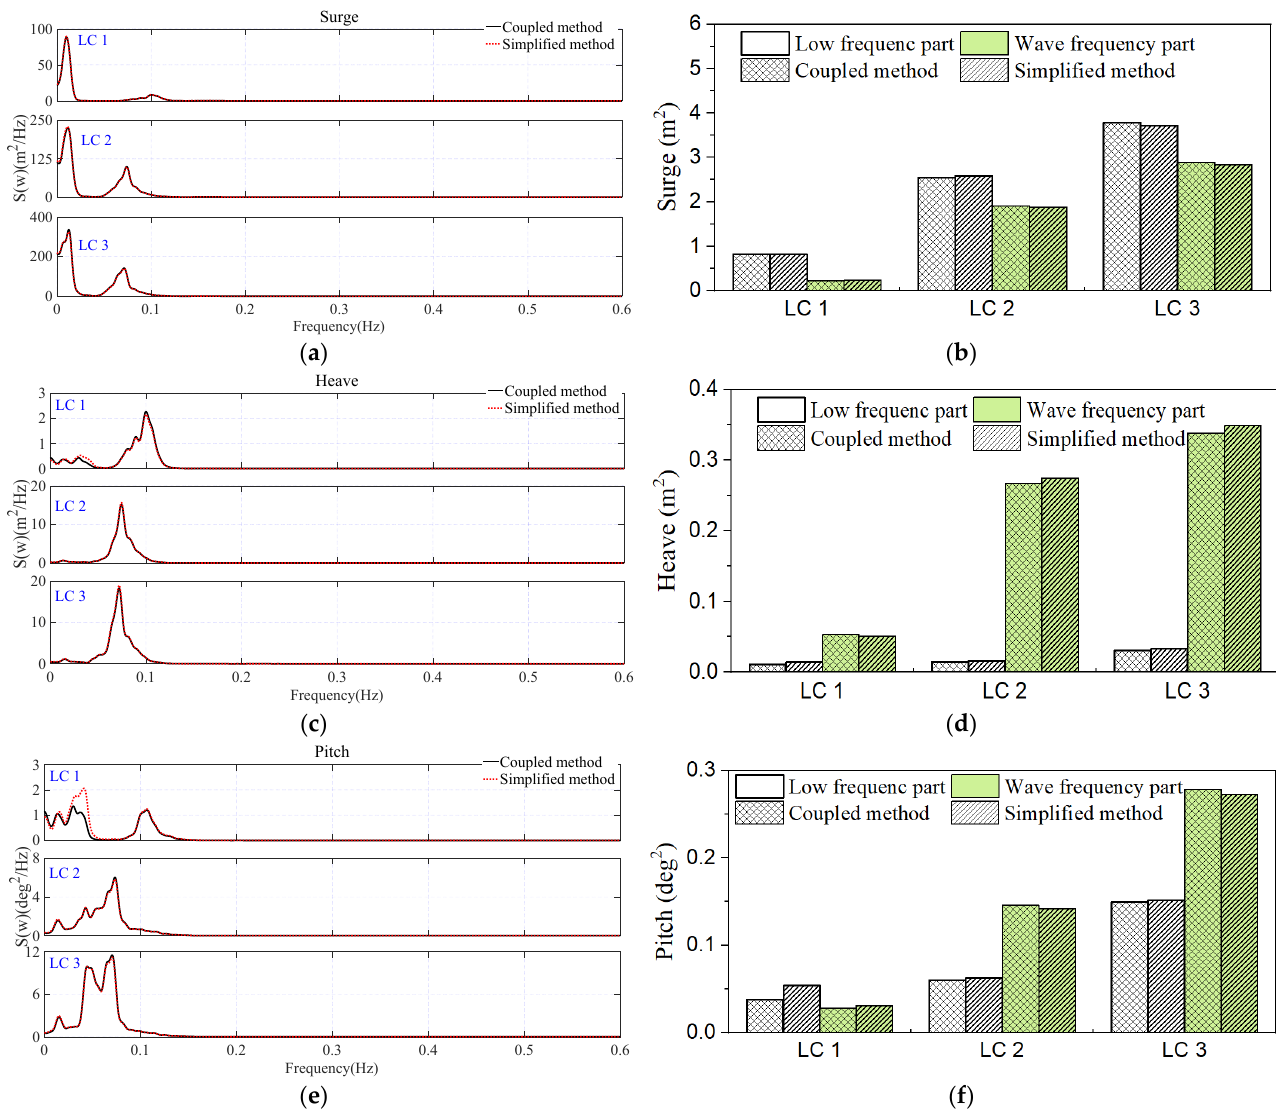
Figure 13. PSD plot of surge, heave, and pitch motion for WindFloat SFOWT platform under different load cases: ( a ) Surge; ( b ) Integrals of surge; ( c ) Heave; ( d ) Integrals of heave; ( e ) Pitch; ( f ) Integrals of pitch.